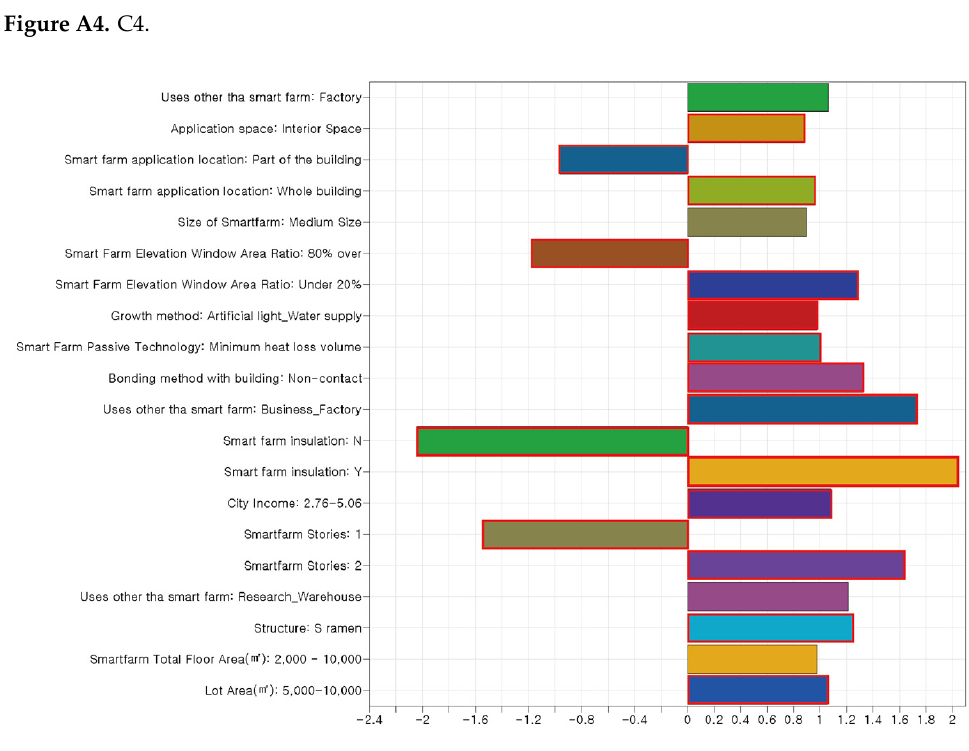
Figure A5. C5. Figure A5.